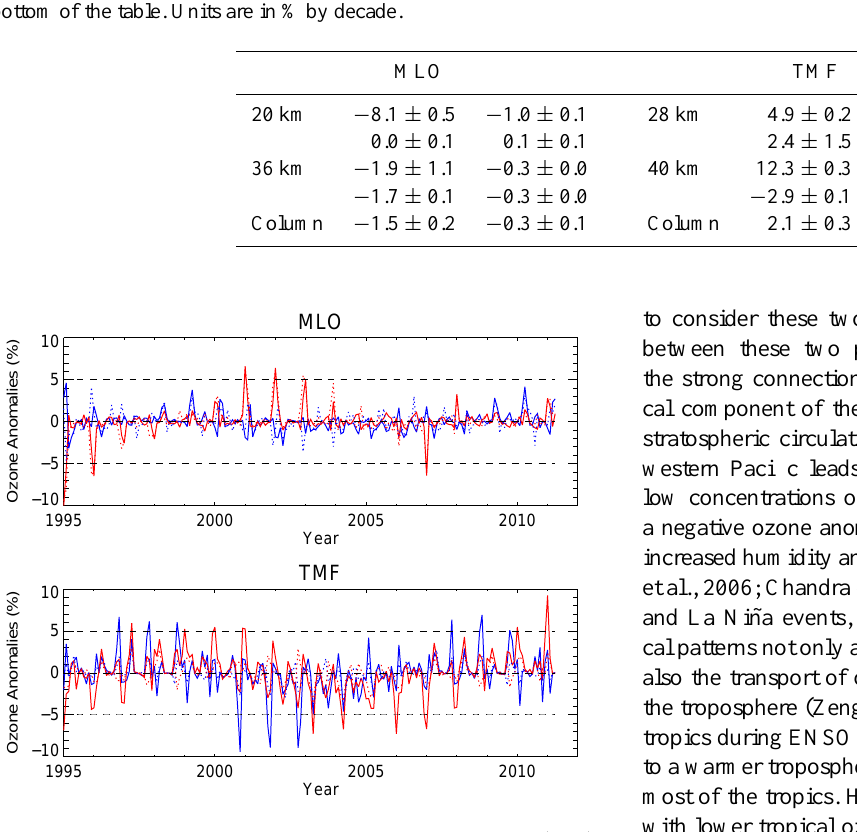
Fig. 12. Ozone response to INTEQL-H perturbations at 22 (blue) and 34 (red) km over MLO and TMF. Lidar responses are solid lines and satellite are dotted